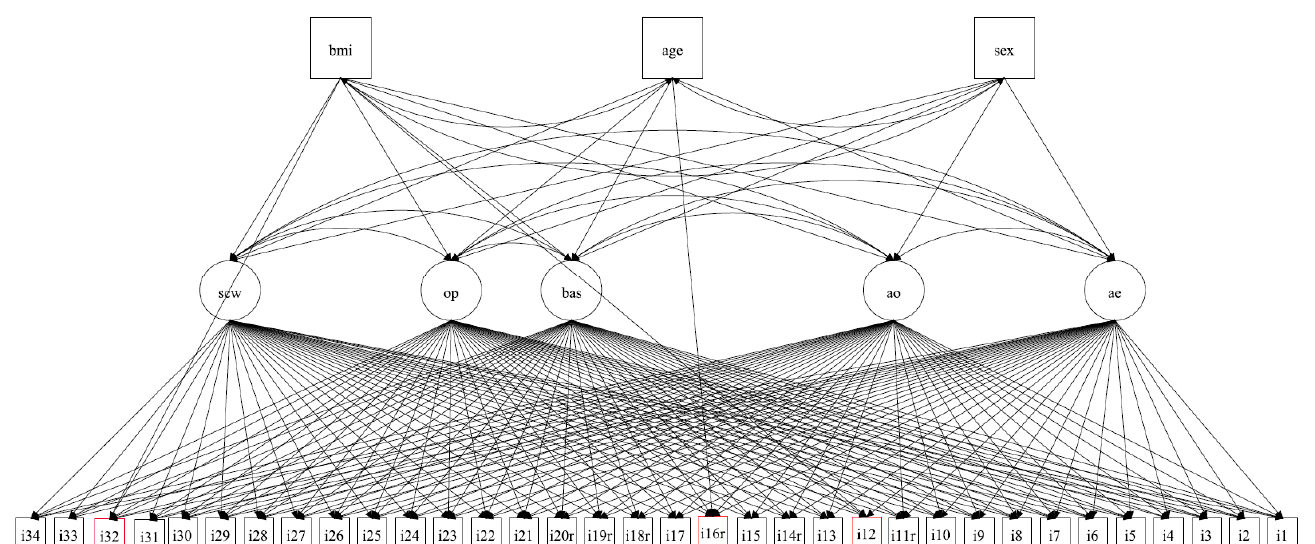
Figure 1. MIMIC Figure 1. MIMIC model.